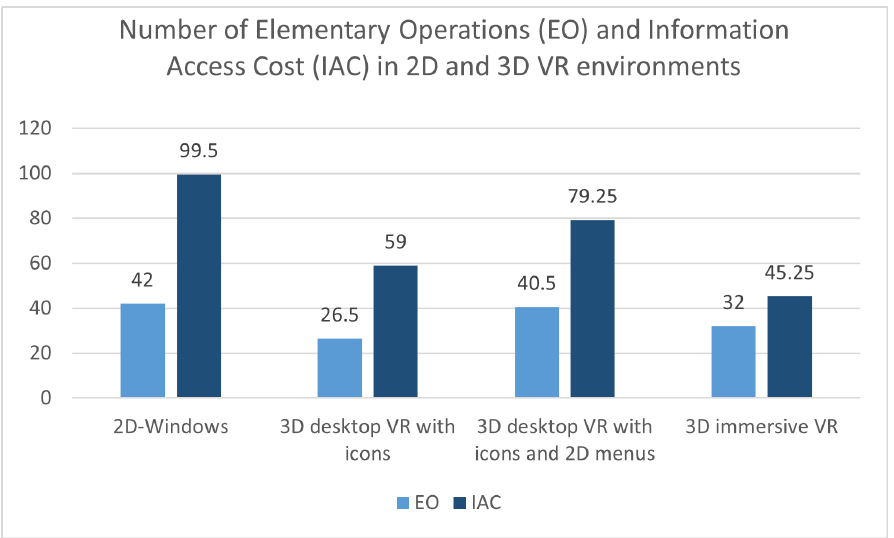
Figure 4. Diagram presenting the number of Elementary Operations (EO) and Information Access Costs (IAC) in the analyzed productivity